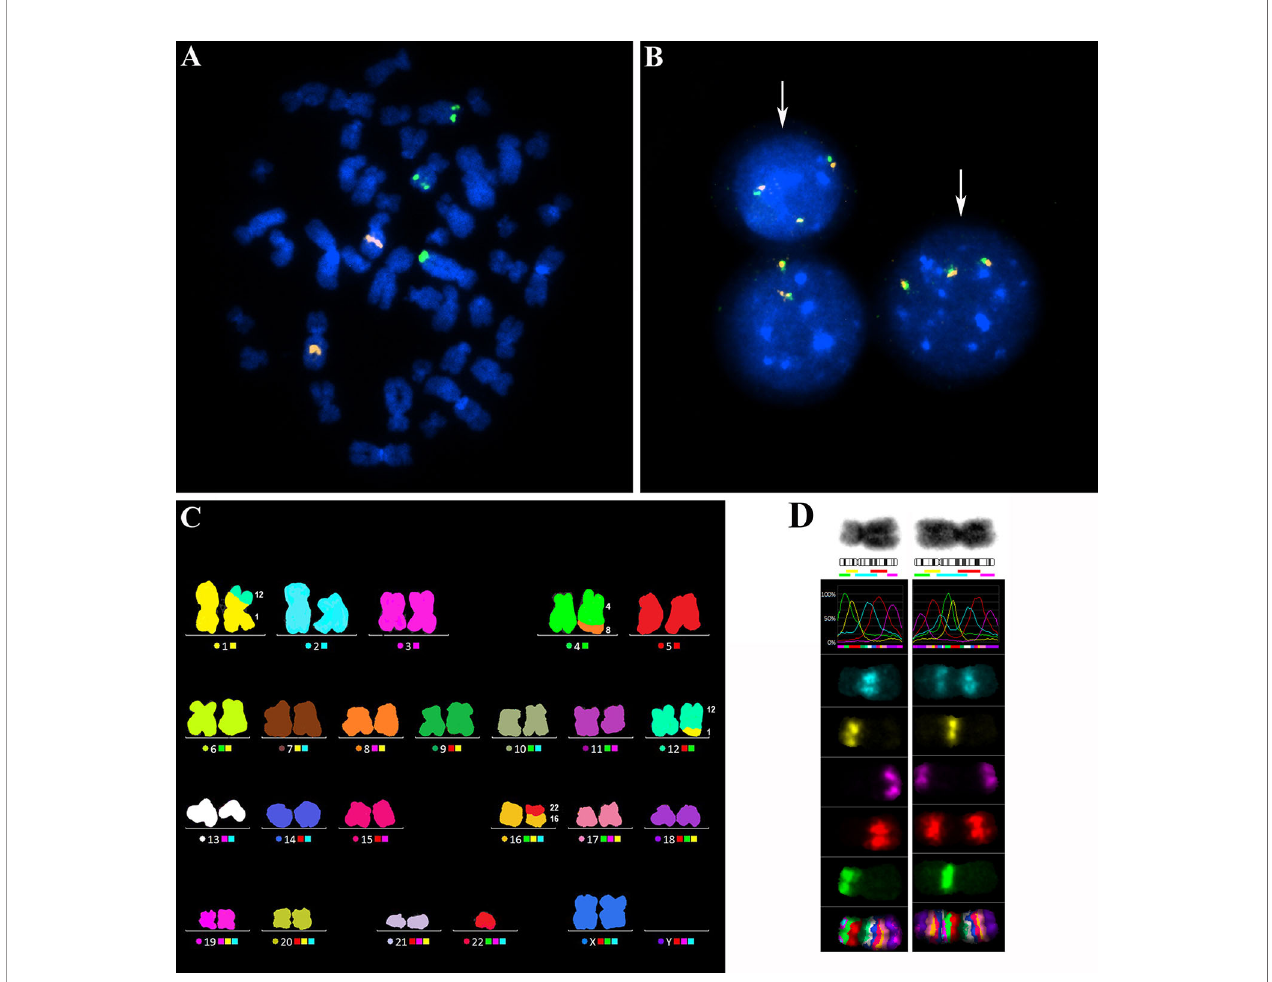
gene (white arrows), visualized by the FISH method using the MYC break-apart probe (ZytoVision). This probe surrounds the common break sites for MYC gene translocations. The orange-green fusion signals indicate that the break site is not in proximity to the MYC regulatory regions. (C) A representative metaphasis hybridized with the M-FISH probe 24XCyte (MetaSystems) for FISH analysis of the whole karyotype. In this metaphasis, one balanced translocation t(1;12) and two unbalanced translocations dic(16;22) and der(4)t(4;8) with 8q gain were detected. (D) Analysis of the extent of 8q gain using the M-BAND8 probe XCyte8 (MetaSystems). Normal chromosome 8 (on the left) and a derivative chromosome 8 (on the right) with the duplicated 8q13-8qter region on an